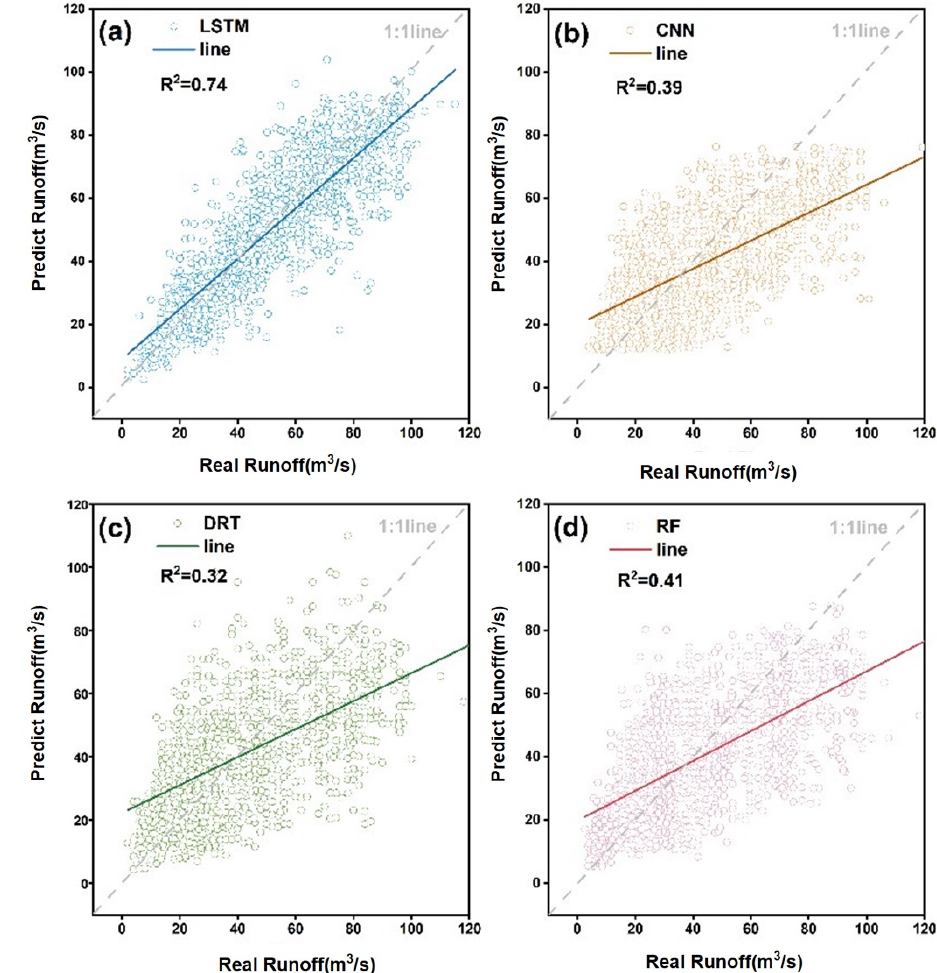
Figure 7. Comparison of prediction results of LSTM ( a ), CNN ( b ), DTR ( c ), and RF ( d ).